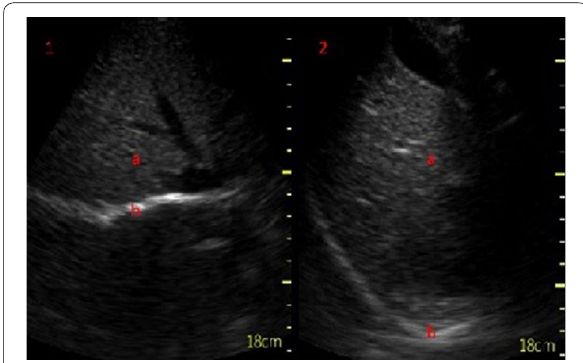
Fig. 1 Subcostal view of the diaphragm (b) in B-mode at end inspiration (1) and at expiration (2) seen below the liver (a)